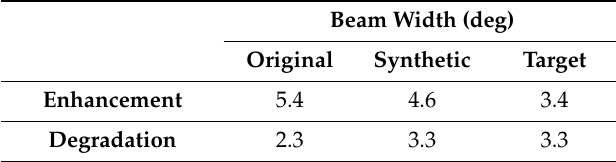
Table 1. The beam widths of the response functions before and after